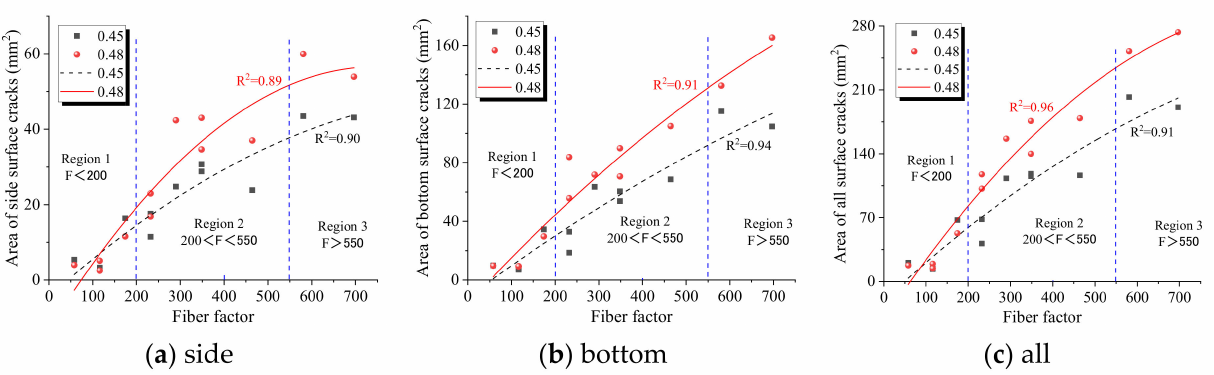
Figure 10. Relationship between fiber factor and crack